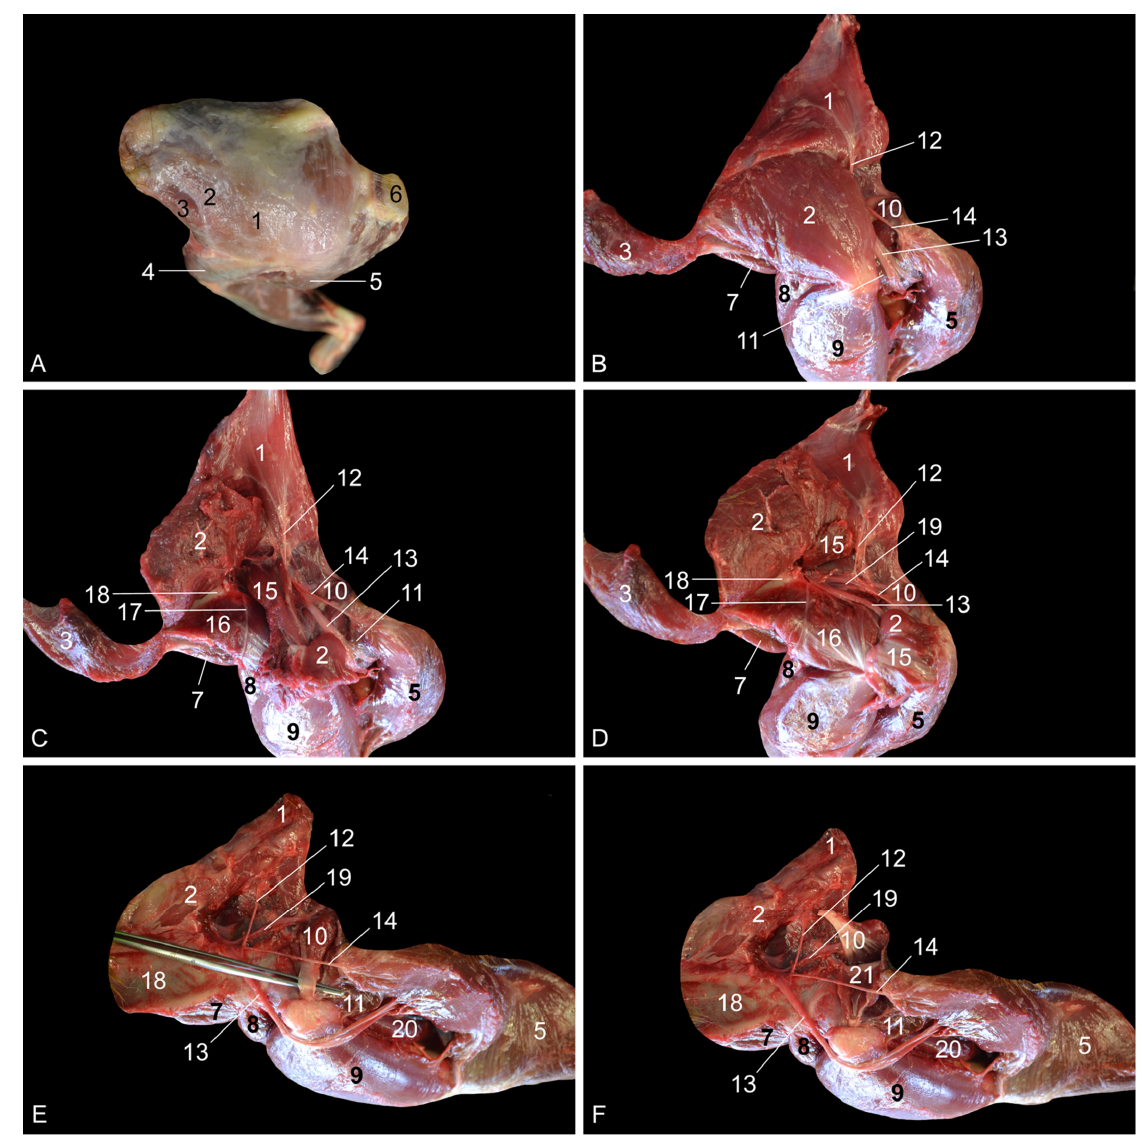
Figure 1. Dorsolateral views of the left hip region. ( A ) Superficial layer; ( B ) second layer after the m. gluteus superficialis and the m. tensor fasciae latae were retracted, and the m. vastus lateralis was detached from the m. biceps femoris; ( C ) third layer after the m. gluteus medius was retracted; ( D ) fourth layer after the m. piriformis was retracted; ( E ) fifth layer after removal of the stump of the m. gluteus profundus, and lateral retraction of the n. ischiadicus; ( F ) deepest layer after the